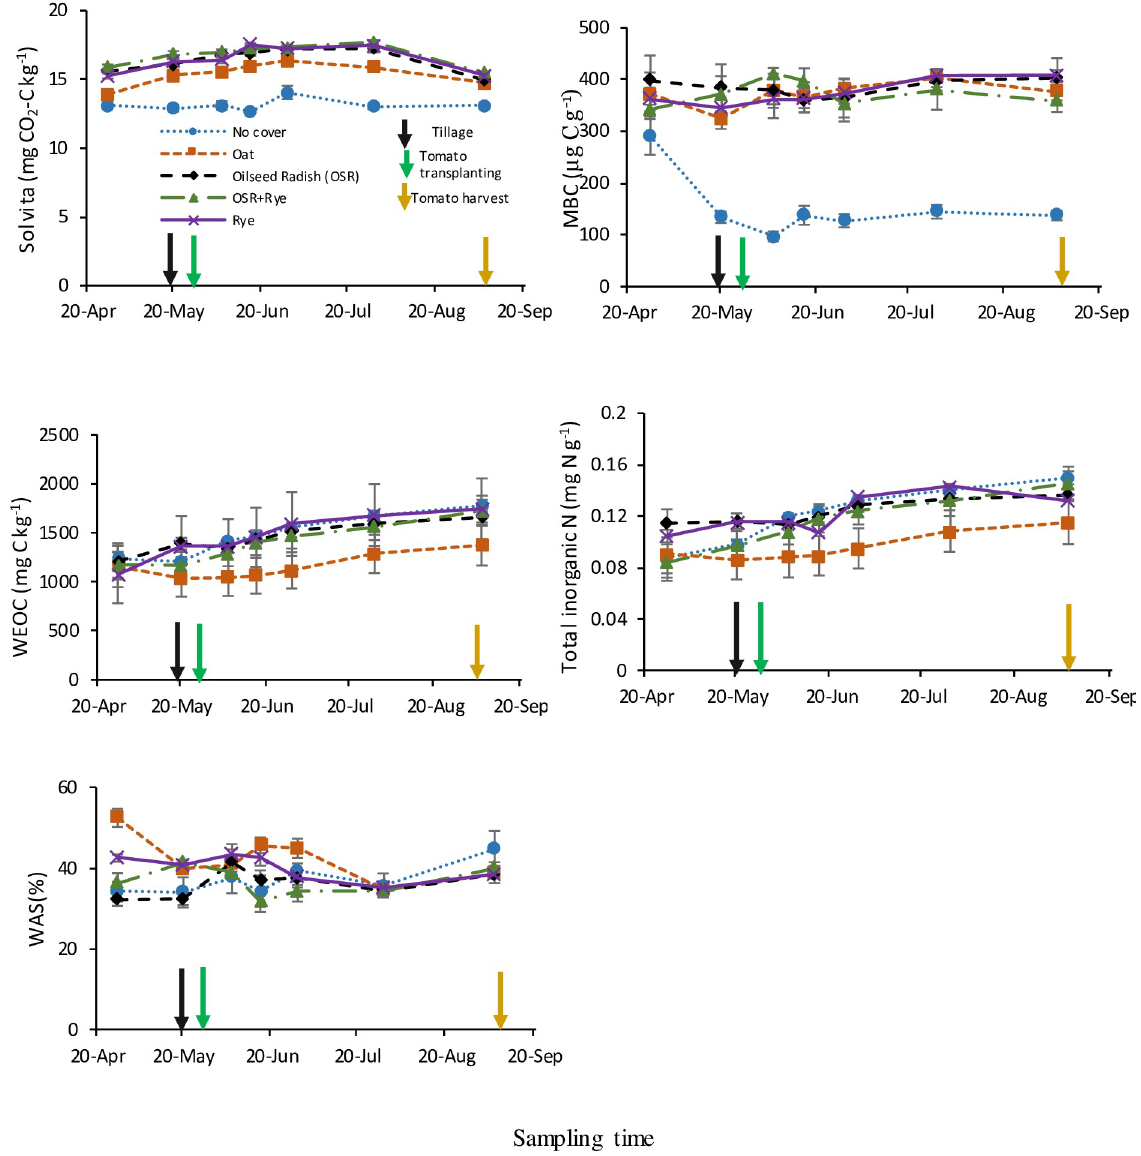
Fig 4. Over the tomato growing season, effect of medium-term summer-planted cover crop (6-yrs) on soil labile fractions of C from 0–15 cm depth in site-year 2016. Bars represent standard error of means (n = 8). MBC, microbial biomass C; WAS, wet aggregate stability; WEOC, water extractable organic